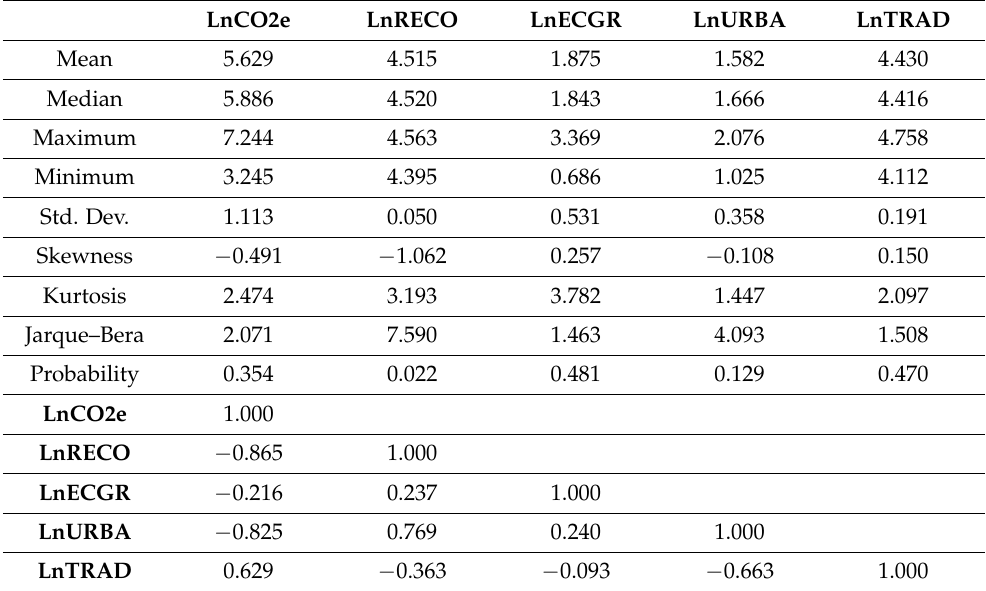
Table 3. Descriptive analysis and variable correlation.